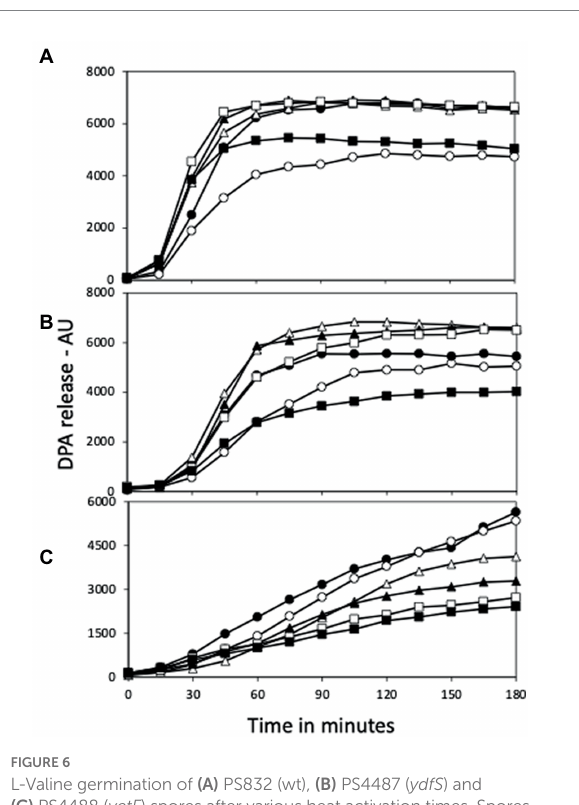
FIGURE 5 Germination of spores with or without yetF or ydfS with (A) L-valine, (B) AGFK or (C) dodecylamine. Spores of strains PS832 (wt – ○ ), PS4487 ( ydfS – ● ), and PS4488 ( yetF – △ ) were optimally heat activated at 80 ° C (A,B) , cooled, and germinated with (A) L-valine, (B) AGFK or (C) dodecylamine as described in Methods, and spore germination was measured by release of CaDPA and expressed as relative fluorescence units (RFU). Values in (A,B) are averages of duplicate determinations, while values in (C) are from single measurements. Spores of all three strains used in this experiment had essentially identical amounts of CaDPA (data not shown). Values in (A,B) are from samples given the optimum heat activation times for germination with L-valine (Figures 6A–C) which were: (A) – 105 min, (B) – 60 min, and (C) – 30 min; or with AGFK (Figures 7A–C)